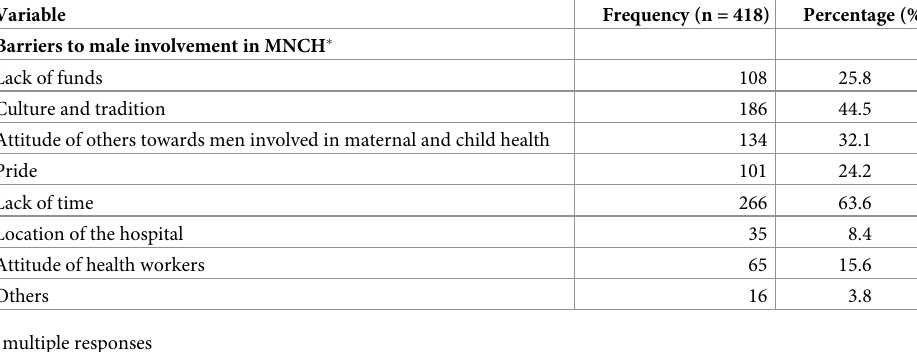
Table 8. Barriers to male involvement in maternal and child health